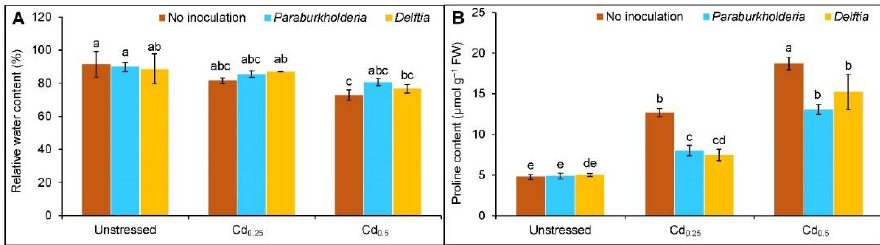
Figure 2. Effect of Paraburkholderia fungorum and Delftia sp. on the ( A ) relative water content (RWC) and ( B ) proline (Pro) content of rapeseed under different levels of CdCl 2 . Here, Cd 0.25 and Cd 0.5 indicated 0.25 and 0.5 mM CdCl 2 , respectively. Different letters on the bars indicate statistical significance at 5% levels of probability following Tukey’s HSD test and the mean (±SD) values obtained from three replications.